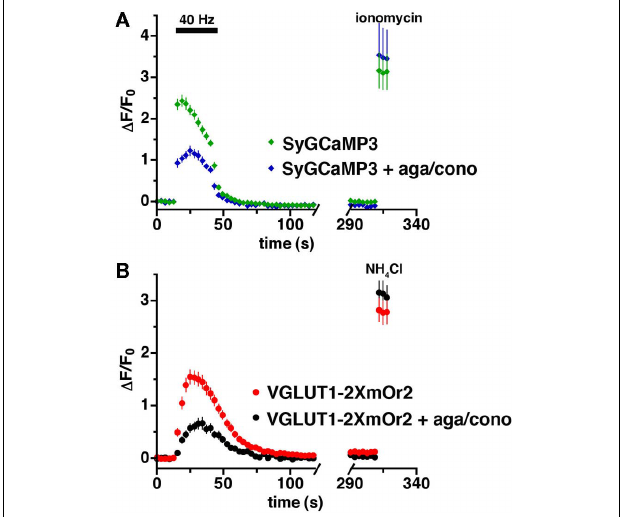
FIGURE 4 | No effect of P/Q- and N-type calcium channel inhibition on endocytosis. (A) The time course of changes in average fluorescence intensity of boutons expressing both SyGCaMP3 in the absence (green) and presence (blue) of agatoxin and conotoxin during and after stimulation at 40Hz for 30s. Calcium channel blockers reduce calcium levels but do not affect the decay of SyGCaMP3 fluorescence. (B) Time course of fluorescence changes ofVGLUT1-2XmOr2 in the absence (red) and presence (black) of the channel blockers.The rate ofVGLUT1-2XmOr2 endocytosis is also not changed by addition of P/Q- and N-type calcium channel blockers. Data are means ± SEM of the change in fluorescence ( Δ F ) normalized to initial fluorescence over at least 30 boutons per coverslip from 7 to 12 coverslips and at least three independent